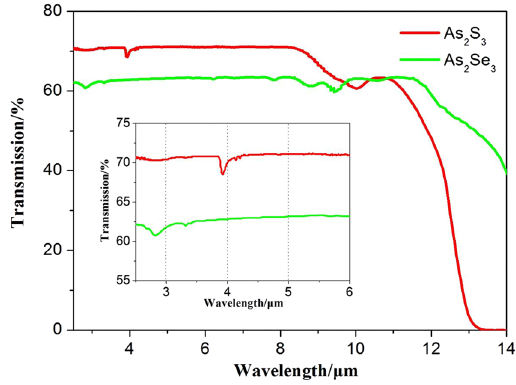
Figure 1. Transmission spectra of As 2 S 3 , the red line, and As 2 Se 3 , the green line. The inset shows the spectra from 2.5 to 6 μ